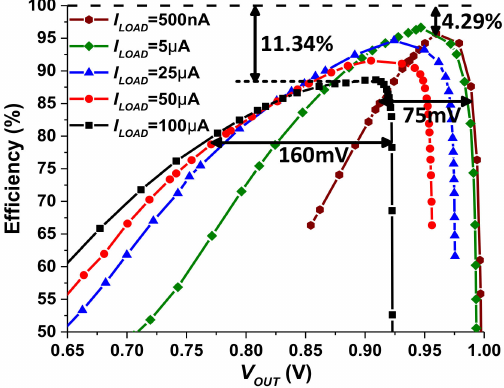
Figure 3. Efficiency of the 2:1 SC converter at varying